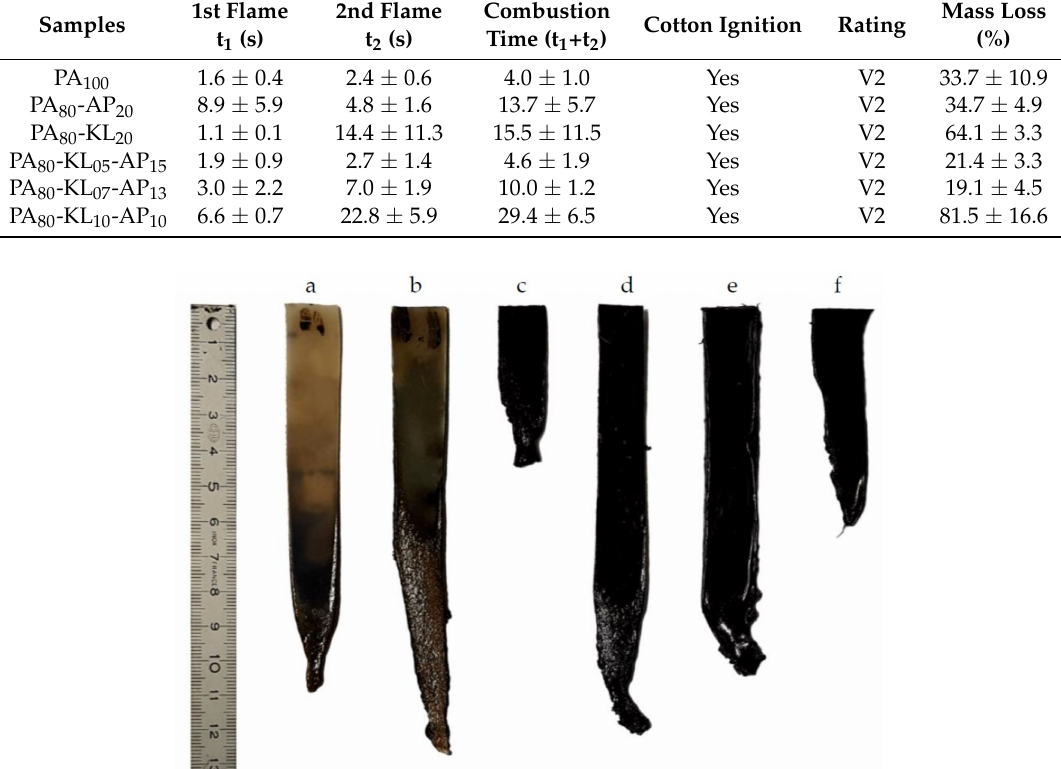
Figure 5. Pictures of PA blends specimen left after UL 94 vertical flame test. ( a ) PA; ( b ) PA 80 -AP 20 ; ( c ) PA 80 -KL 20 ; ( d ) PA 80 -KL 05 -AP 15 ; ( e ) PA 80 -KL 07 -AP13; ( f ) PA 80 -KL 10 -AP 10